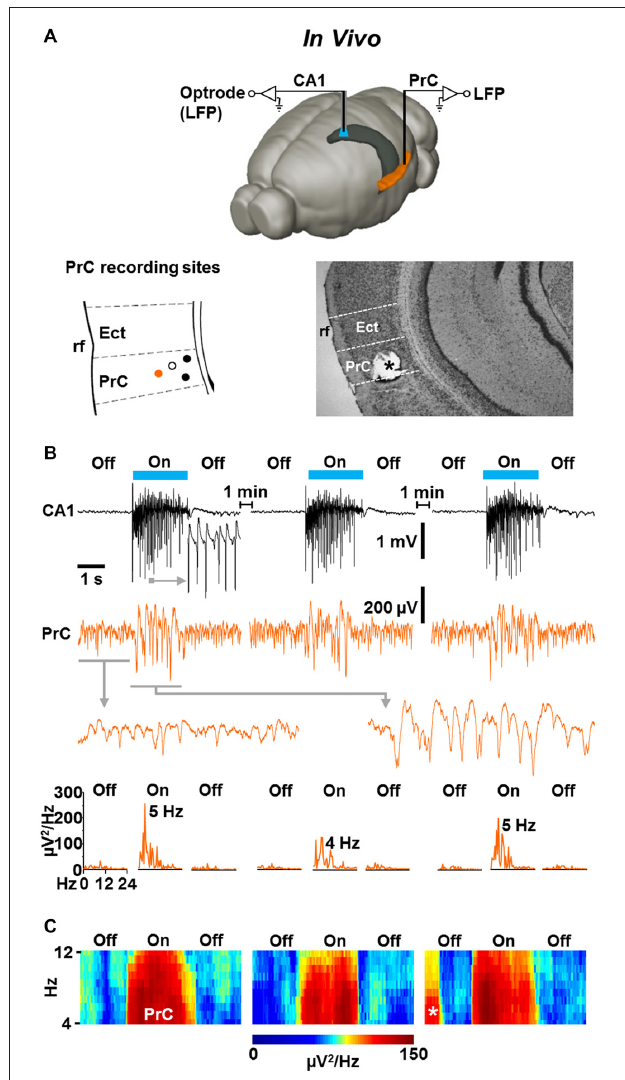
FIGURE 5 | Light-induced fast CA1 network oscillations in NEX-Cre-ChR2 mice are accompanied by concurrent states of enforced theta activity in the ipsilateral PrC. (A) Experimental setting (upper panel) and schematic illustration of PrC recording sites in a part of a coronal brain section (lower left panel; Ect, ectorhinal cortex; rf, rhinal fissure). Closed circles represent recording sites where enforced theta activity was detected. Closed orange circle indicates the recording site in the experiment shown in (B) . Open circle marks recording site at which no enforced theta activity was detected. Lower right panel: for verification of PrC recording sites, electrical lesions were set after electrophysiological measurements. Asterisk marks the position of the recording electrode in the experiment shown in (B) . (B) Representative recording traces (and enlarged portions of the traces) depicting the CA1 and simultaneous PrC network activities during the repetitive “light off-on-off” protocol used. Lower panels give power spectra for the PrC measurements. (C) Average spectrograms for the PrC recordings marked by closed circles in the lower left panel in (A) . Asterisk indicates prominent spontaneous theta